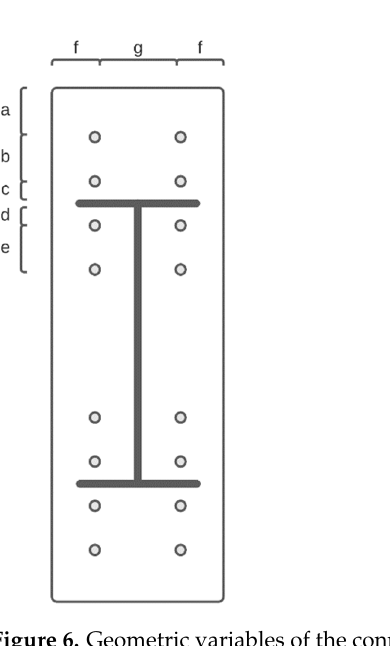
Figure 6. Geometric variables of the connection plate. Source: the authors.